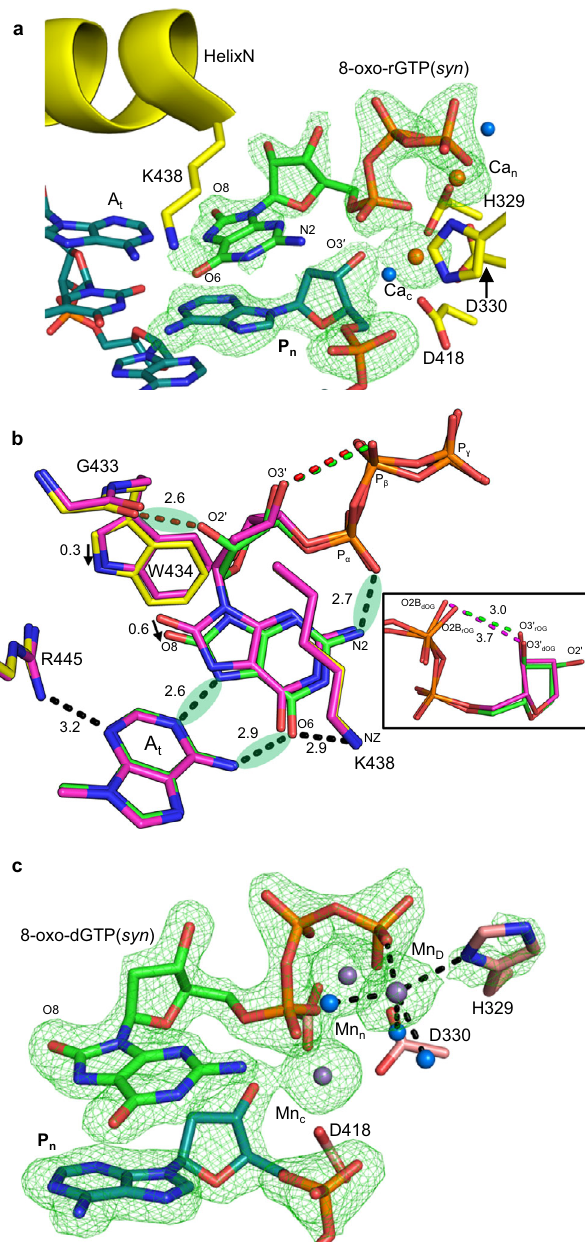
Fig. 4 Ground state 8-oxo-rGTP(syn):A t ternary complex. a Active site of the Ca 2 + -bound pre-catalytic ground state 8-oxo-dGTP(syn):A t ternary complex. Protein sidechains (yellow), DNA (cyan), and nucleotide (green) are shown in stick representation, Helix N is the yellow cartoon. Ca 2 + atoms are the orange spheres, water molecules are blue spheres. Simulated annealing omit density (green mesh) is contoured at 3 σ . b Comparison of active site nucleotide interactions in the Ca 2 + -ground state 8-oxo-rGTP (syn):A t (green and yellow) and 8-oxo-dGTP(syn):A t (magenta) ternary complexes. Hydrogen bonding (Å) and key distances (Å) are shown with black and red dashes, respectively. Green spheres indicate (favorable) stabilizing interactions. The inset shows that the distance between O3´ and O2B is altered due to the rigid sugar pucker induced by the ribose (O2´) oxygen. c Mn 2 + -ground state 8-oxo-dGTP(syn):A t ternary complex (15 min soak). An additional metal (Mn D ) coordinates P γ , His329 and 3 water molecules. Black dashes show metal coordination.